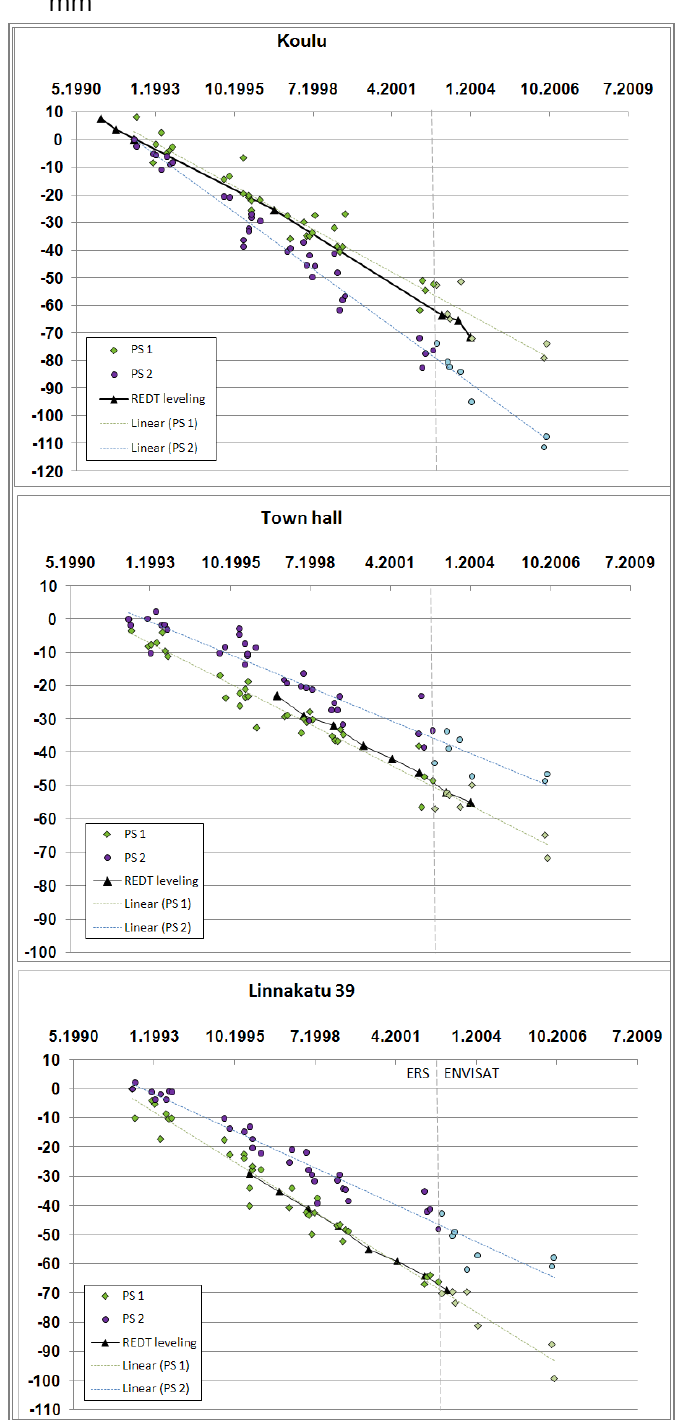
Figure 7. The ERS and ENVISAT time series for 2 PS on three buildings and the linear subsidence based on the PSI observations. For comparison, a REDT leveling time series for a benchmark located in the building is presented. Deformation is zero for the ERS master